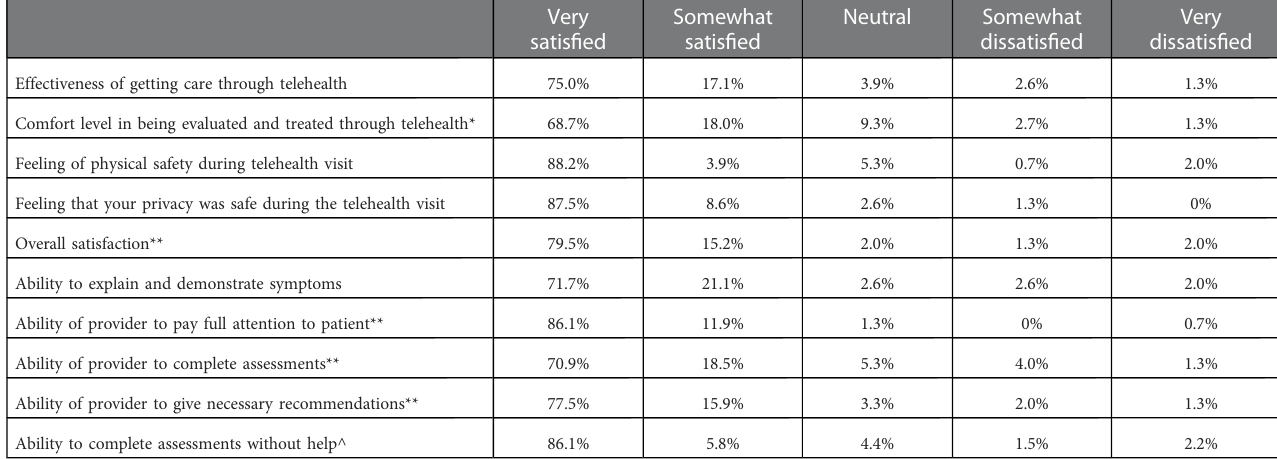
TABLE 2 Patient-reported experience, satisfaction, and effectiveness of